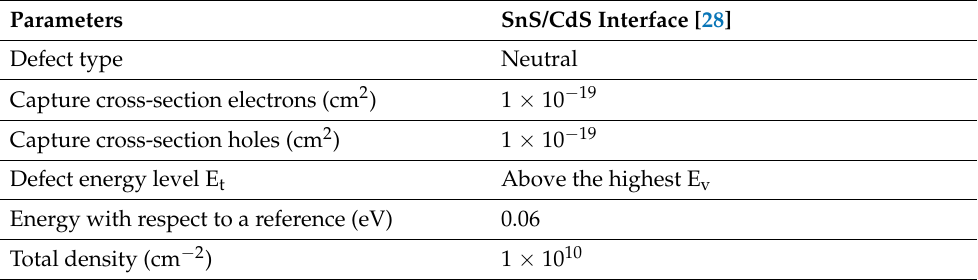
Table 2. Interface parameters used in the simulation of the proposed solar cell.